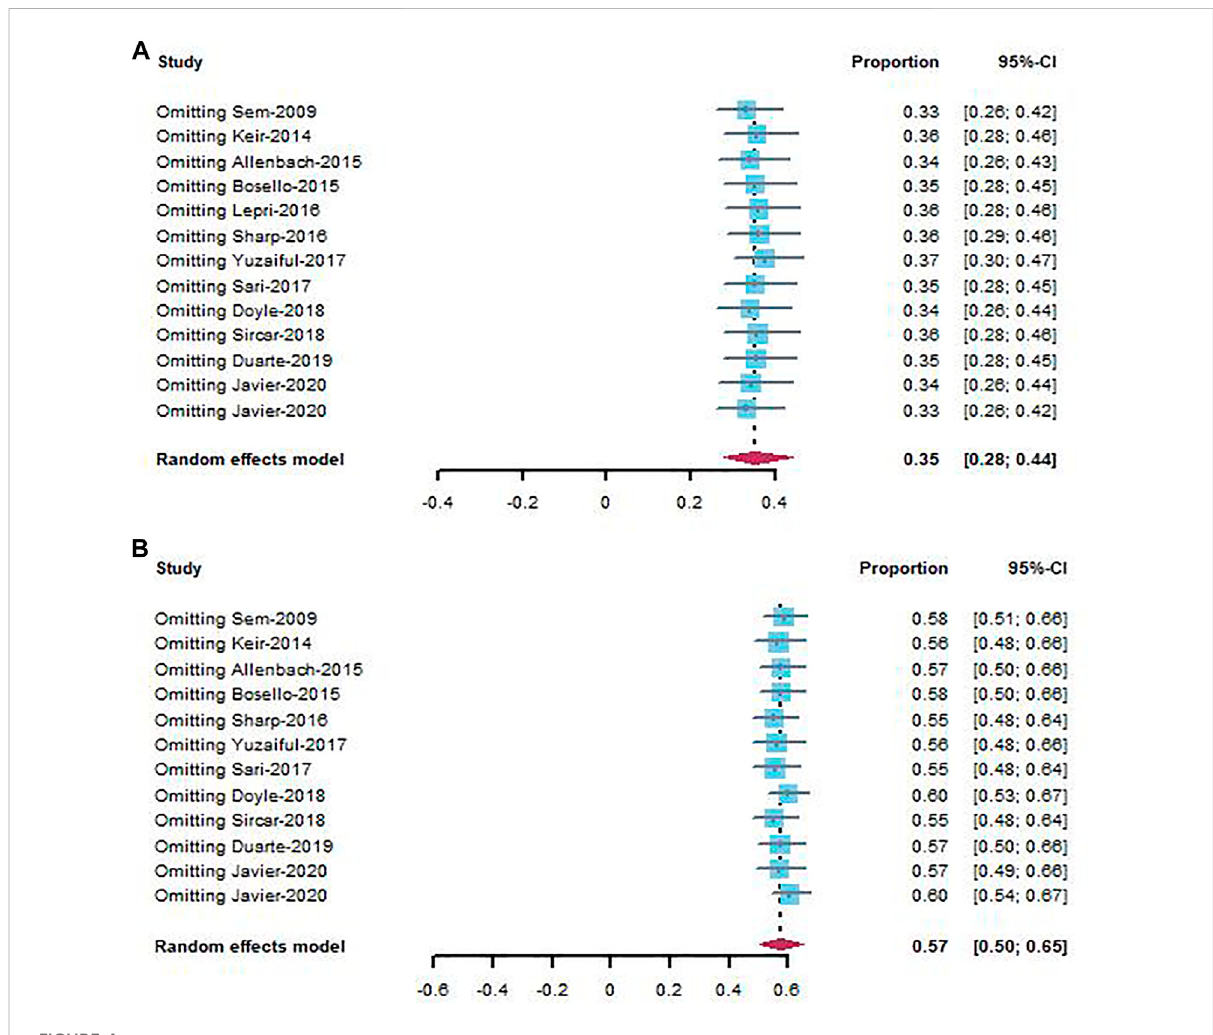
FIGURE 4 Sensitivity analysis of improvement rate (A) and stable rate (B) in CTD-ILD